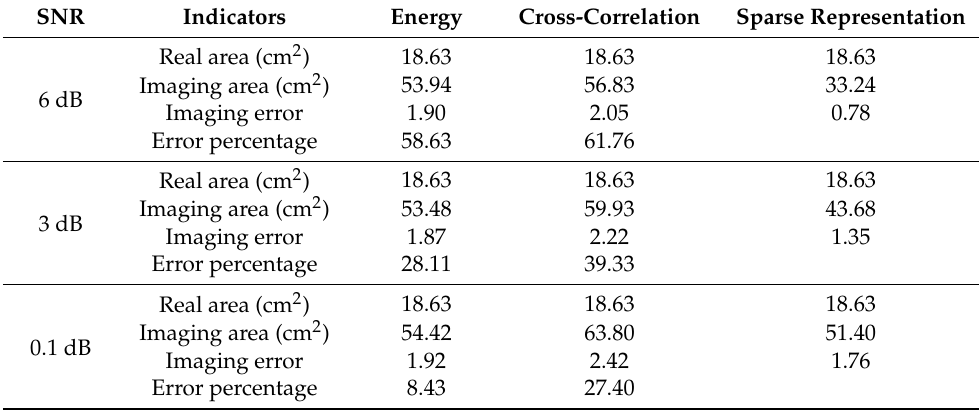
Table 2. Damage imaging error and error percentage under different noise. SNR Indicators Energy